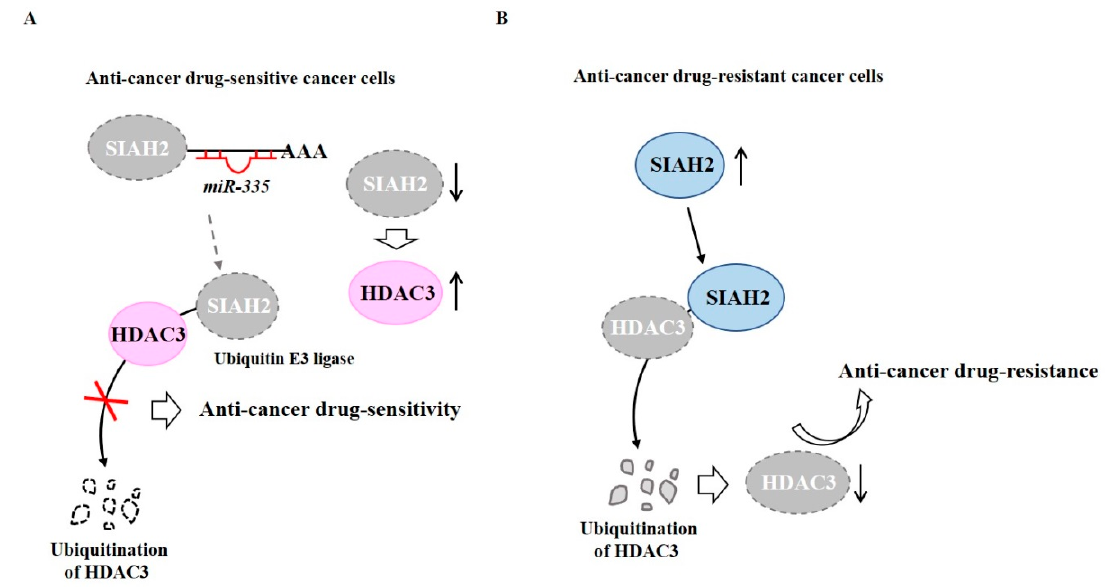
Figure 2. Ubiquitination of HDAC3 leads to decreased expression of HDAC3. ( A ) In anti-cancer drug-sensitive cancer cells, miR-335 binds to 3 ′ -UTR of Seven in Absentia Homolog 2 (SIAH2) (E3 ubiquitin ligase) to decrease expression of SIAH2. However, SIAH2 does not bind to HDAC3. HDAC3 confers sensitivity to anti-cancer drugs. ( B ) In anti-cancer drug-resistant cancer cells, SIAH2 binds to HDAC3 and causes ubiquitination of HDAC3. The lack of HDAC3 confers resistance to anti-cancer drugs. The ↑ arrows denotes increased expression level and ↓ arrows denotes decreased expression level.